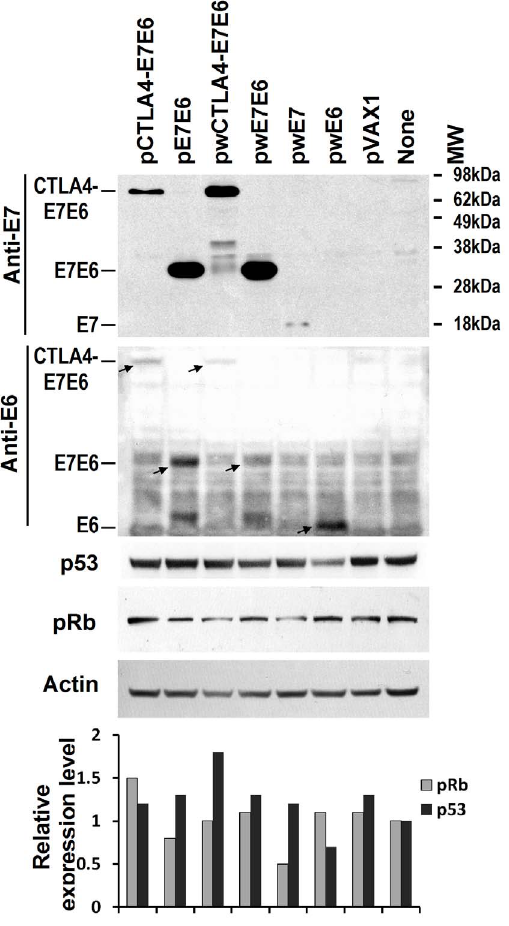
Figure 2. Western blotting analysis of E7E6, p53 and pRb expression. The lysates of 293 cells transfected with pCTLA4-E7E6, pE7E6, pwCTLA4-E7E6, pwE7E6, pwE7, pwE6, pVAX1 or phosphate buffered saline (PBS, labeled as None) were probed with mouse anti-E7, goat anti-E6, mouse anti-p53, rabbit anti-pRb, or mouse anti- b -actin antibody. b -actin served as loading control. pCTLA4-E7E6 encodes CTLA-4 and mutant E7E6 fusion protein. pE7E6 encodes mutant E7E6 fusion protein. Accordingly, pwCTLA4-E7E6 and pwE7E6 carry wild type E7E6 fusion gene. pwE7 and pwE6 encode wild type E7 and E6 respectively. Expressed recombinant proteins were labeled by oblique arrows. MW: molecular weight. The lowest panel showed the relative expression levels of p53 and pRb by normalizing the signal intensities to actin.